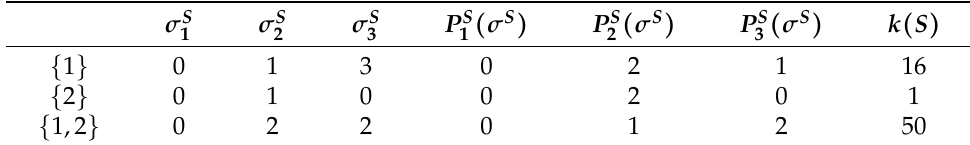
Table 8. An optimal plan for SI-situation.